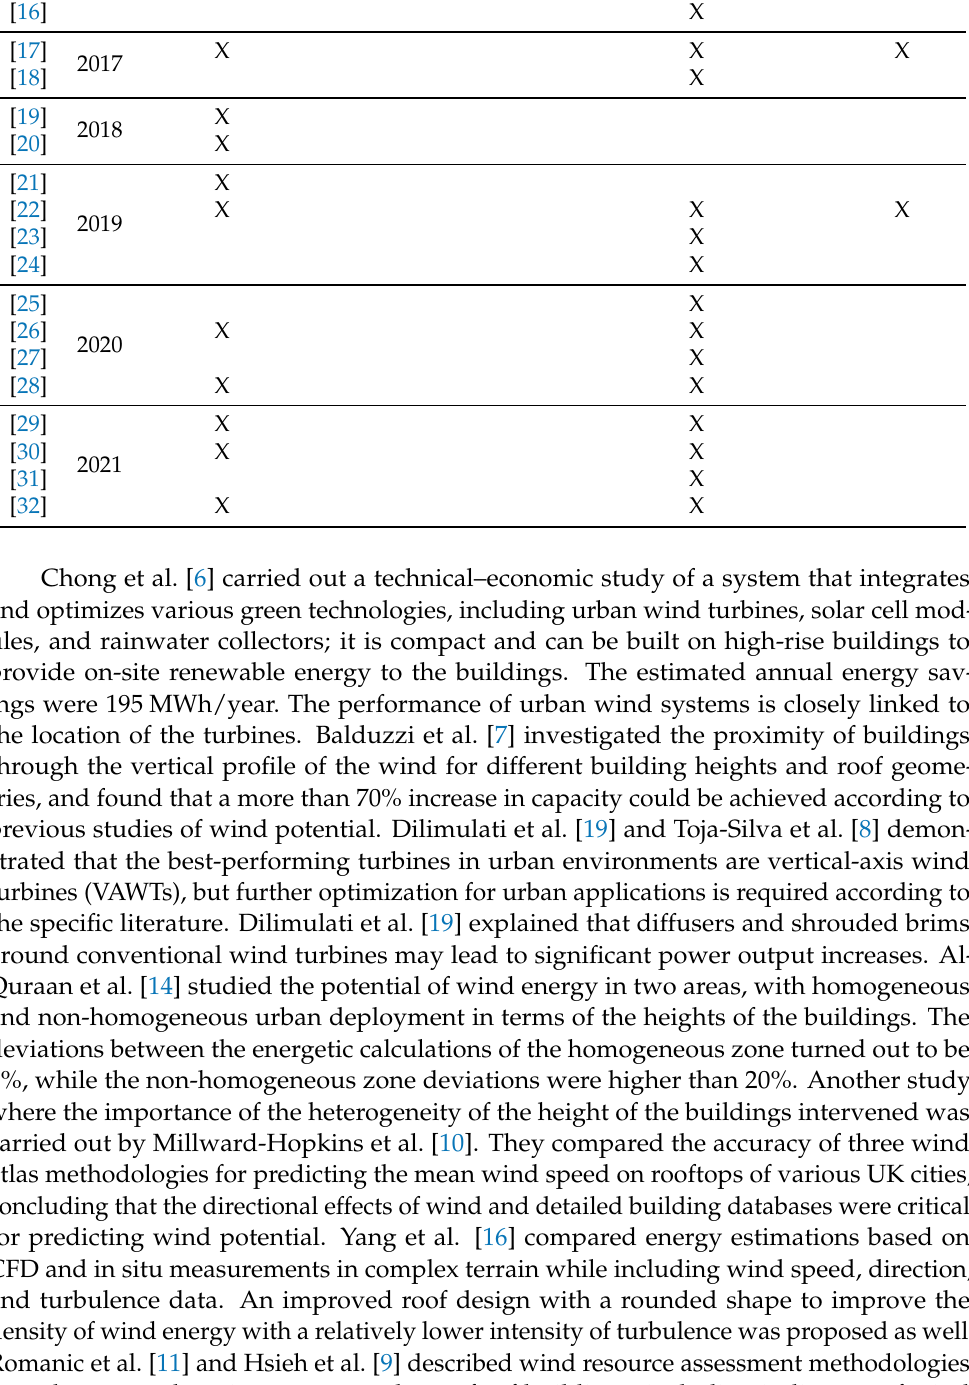
Table 1. Cont . Ref. Year Technological Socio-Environmental Wind Resource